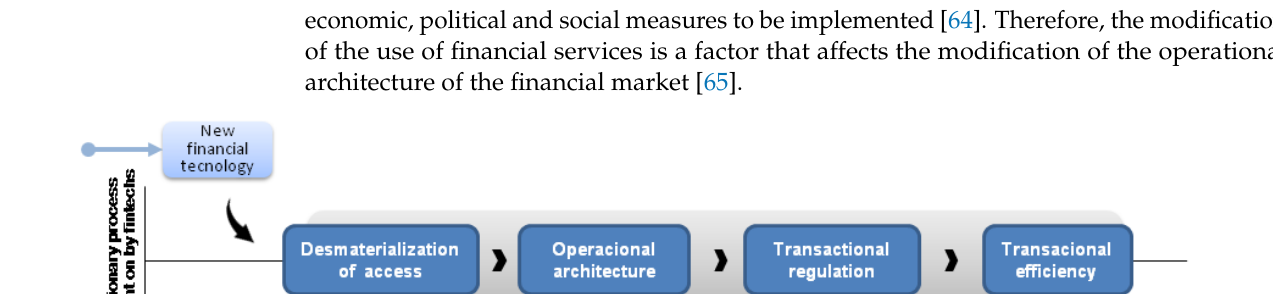
Table 3. A summary of the dimensions and the systematic literature review.